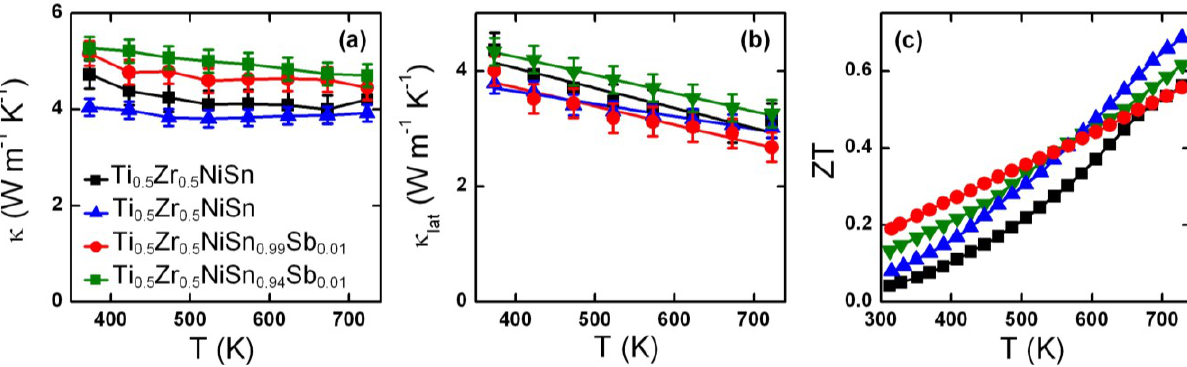
Figure 4. Temperature dependence of ( a ) thermal conductivity (κ); ( b ) lattice thermal conductivity (κ lat ) and ( c ) ZT for the Ti 0.5 Zr 0.5 NiSn 1/0.95−y Sb y